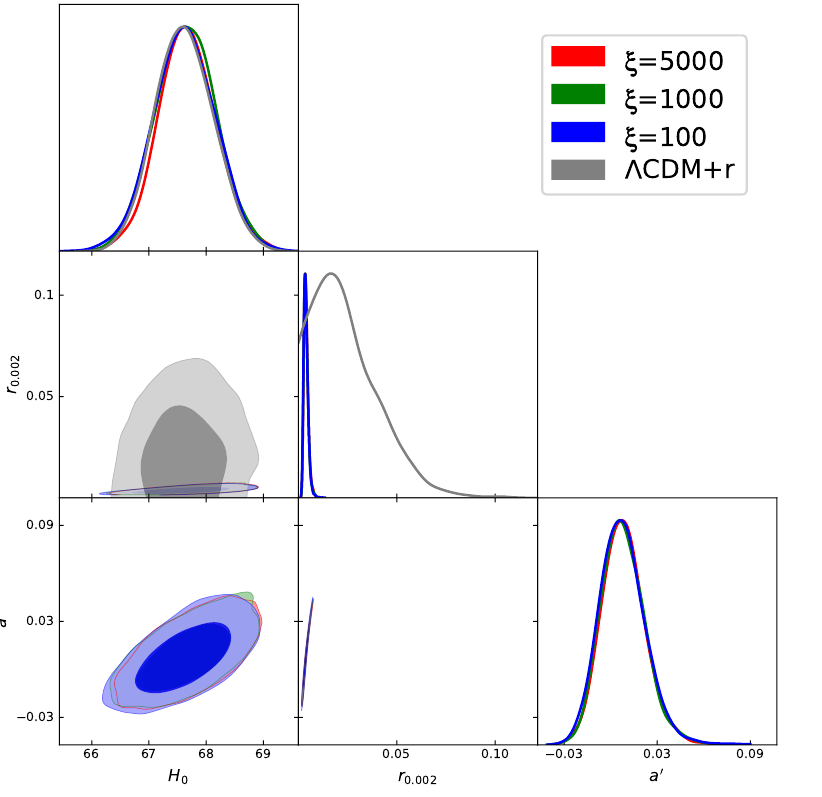
Figure 8 . 2D C.L. and posterior distributions of Higgs Inflation and Λ CDM+r